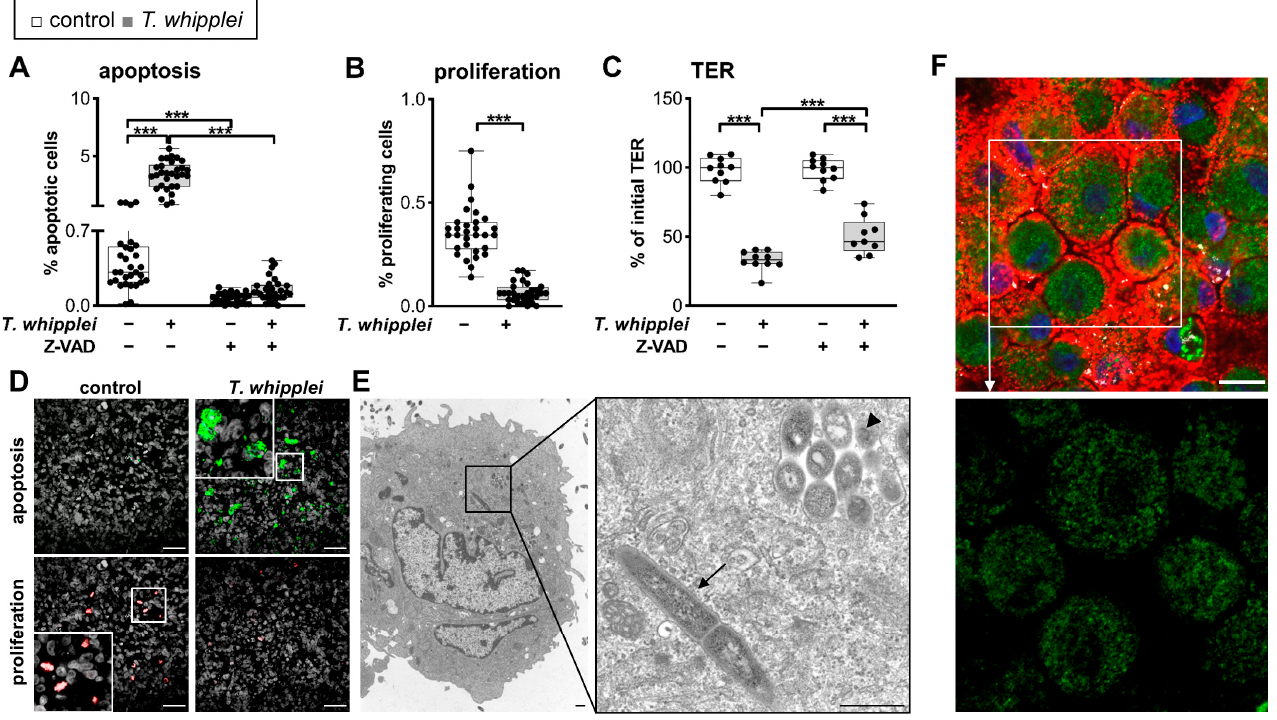
Figure 5. T. whipplei induces epithelial apoptosis. ( A ): Percentage of cleaved caspase-3-positive T84 cells by immunofluorescence (IF) microscopy 24 h after inoculation with TW (multiplicity of infection (MOI) = 100) ± caspase inhibitor ZVAD (50 mM). ( B ): Percentage of Ki-67-positive T84 cells by IF microscopy 24 h after inoculation with TW (MOI = 100). Apoptosis (caspase-3-positive) and proliferation index (Ki-67-positive) were expressed as the percentage of cleaved-caspase3-positive cells and Ki-67-positive cells, relative to the total number of epithelial cells per filter. ( C ): Relevance of TW -induced apoptosis for barrier function. Transepithelial resistance (TER) was measured 24 h after TW inoculation ± ZVAD. Bars represent single values, median, and minimum to maximum, n = 9–30. Significance levels were corrected for multiple comparisons. *** p < 0.001. ( D ): Representative confocal IF images (green: caspase-3, red: Ki-67, white: DAPI). Size bars, 50 µ m. ( E ): Transmission electron microscope image of a detached apoptotic T84 cell revealing intact intracytosolic (arrow) and intravesicular (arrowhead) TW rods. Detached cells were obtained from the apical supernatant of a T84 epithelial monolayer. Criteria for apoptosis: rounded, single cell, cell shrinkage, and nuclear fragments. Size bars, 0.8 µ m. ( F ): Confocal IF images of TW passage into the macrophage compartment through the epithelial layer, as revealed by the coculture model of Caco-2 cells and primary human macrophages. Macrophages attached to the well bottom are HLA-DR-positive (red) and contain epithelial actin-GFP (green) as well as TW -positive material (white). Size bar, 20 µ